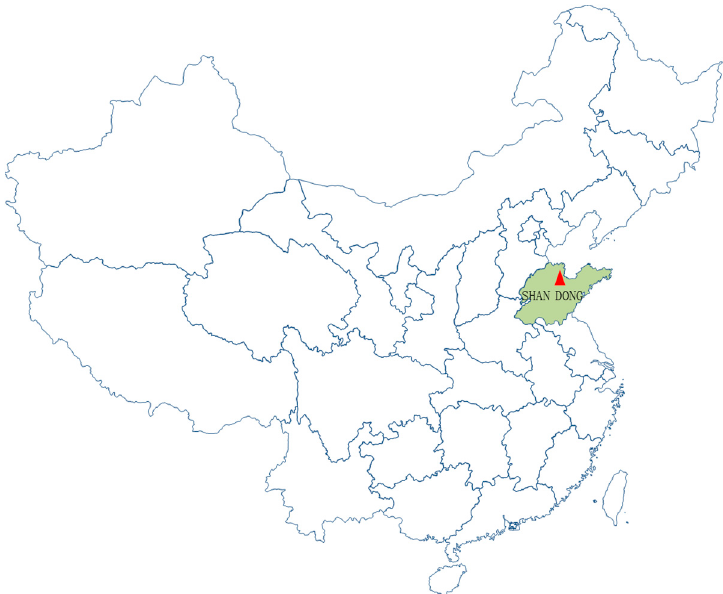
Figure 1. Display of the study site on the map. The red triangle indicated the study site, which was was located in Guangrao District, Dongying City (37 ◦ 17 (cid:48) 53.45 (cid:48)(cid:48) N, 118 ◦ 37 (cid:48) 15.04 (cid:48)(cid:48) E), Shandong located in Guangrao District, Dongying City (37°17 ′ 53.45 ″ N, 118°37 ′ 15.04 ″ E), Shandong Province, Province, China.